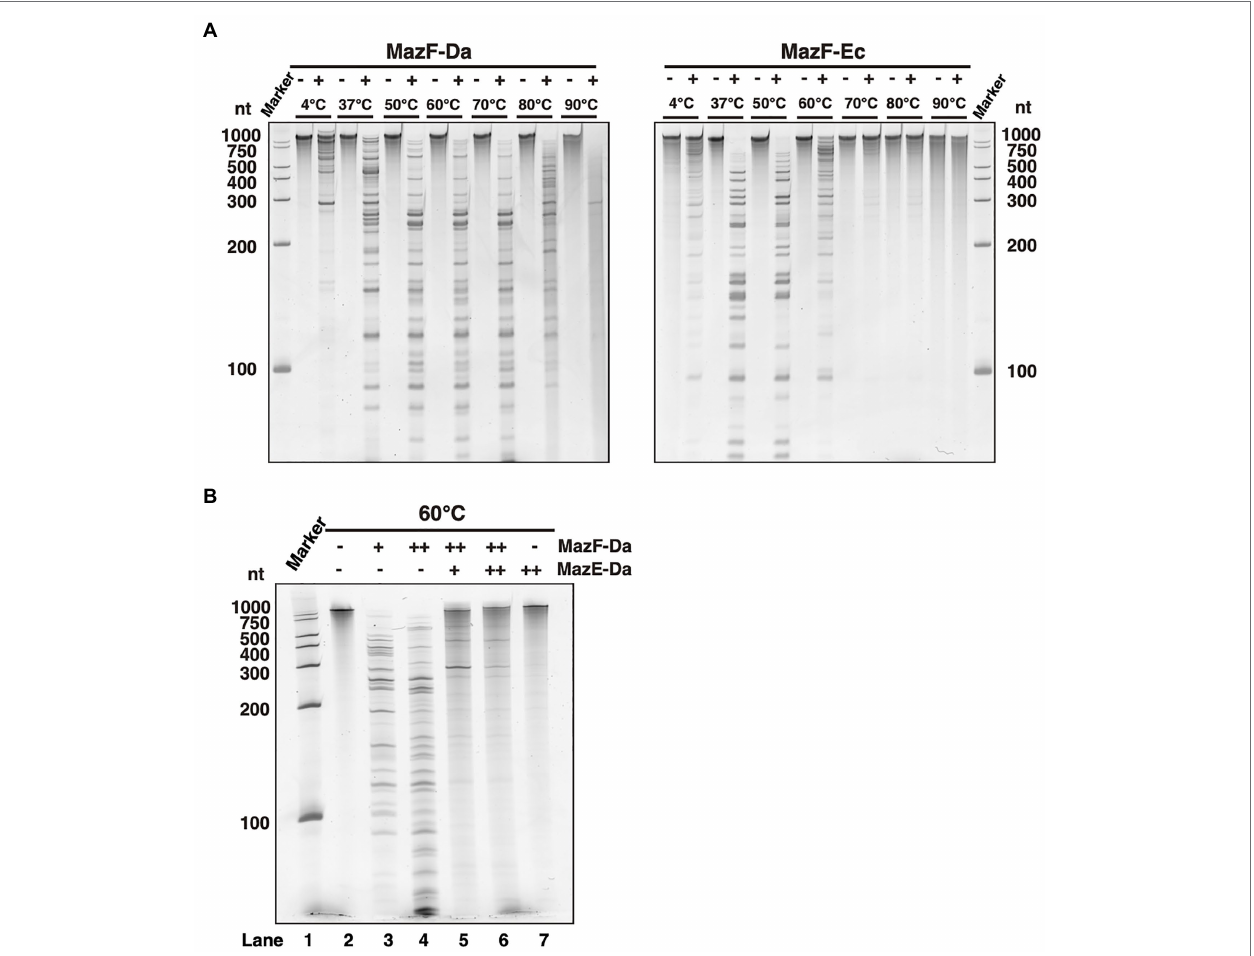
FIGURE 2 | Enzyme activity of MazEF-Da at various temperatures. (A) MazF-Da (left side) and MazF-Ec (right side) were incubated with the substrate RNA at 4–90 ° C each. The resulting RNA fragments were separated on a 7.5% polyacrylamide gel containing 7 M urea. (B) Substrate RNA was incubated at 60 ° C for 90 min with MazE-Da and/or MazF-Da; lane 1, marker; lane 2, negative control without enzymes; lane 3, 1 pmol of MazF-Da; lane 4, 10 pmol of MazF-Da; lane 5, 10 pmol of MazF-Da and 20 pmol of MazE-Da; lane 6, 10 pmol of MazF-Da and 40 pmol of MazE-Da; lane 7, 40 pmol of